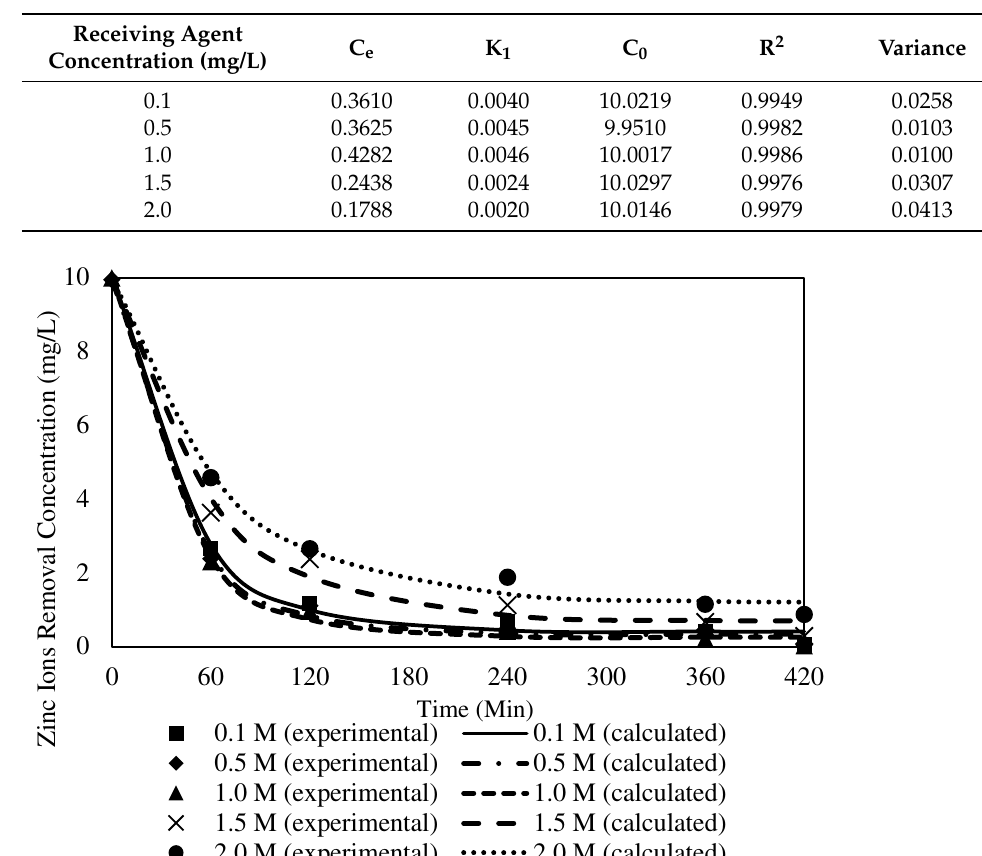
Table 8. The calculated numerical parameter values of the PSO models for the W3 membrane removal process with different receiving agent concentrations.